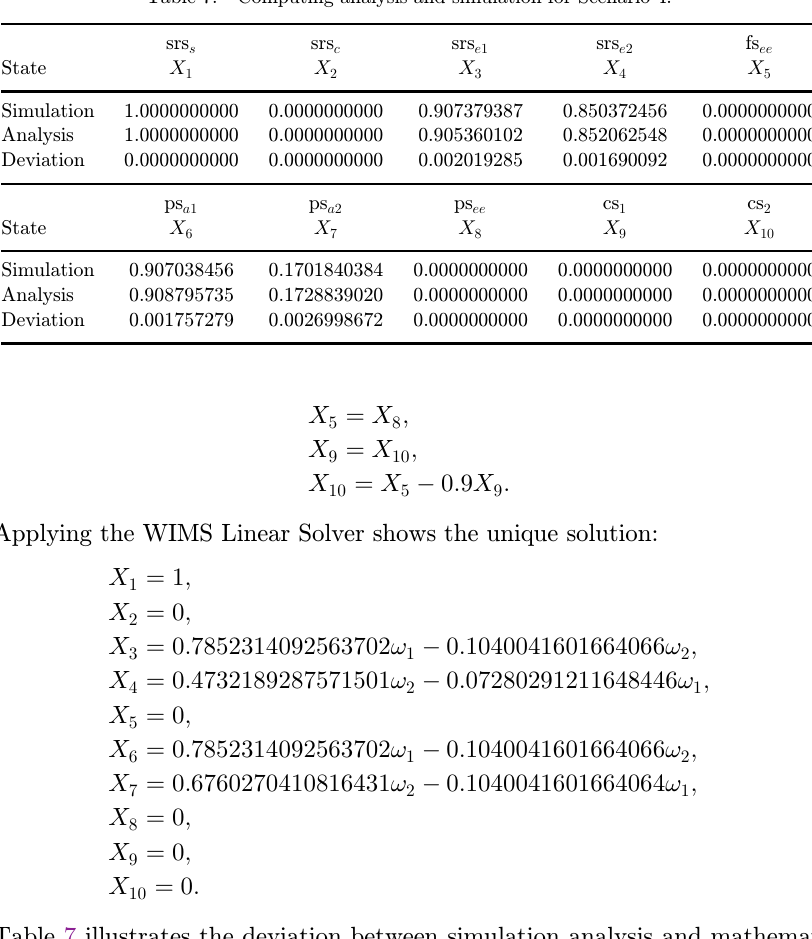
Table 7. Computing analysis and simulation for Scenario